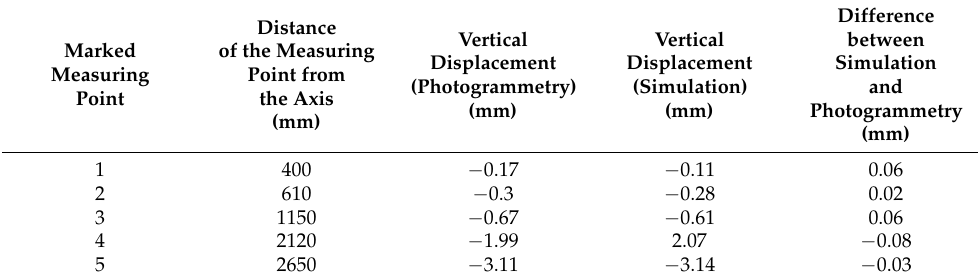
Table 7. Comparison of photogrammetry and simulation results.